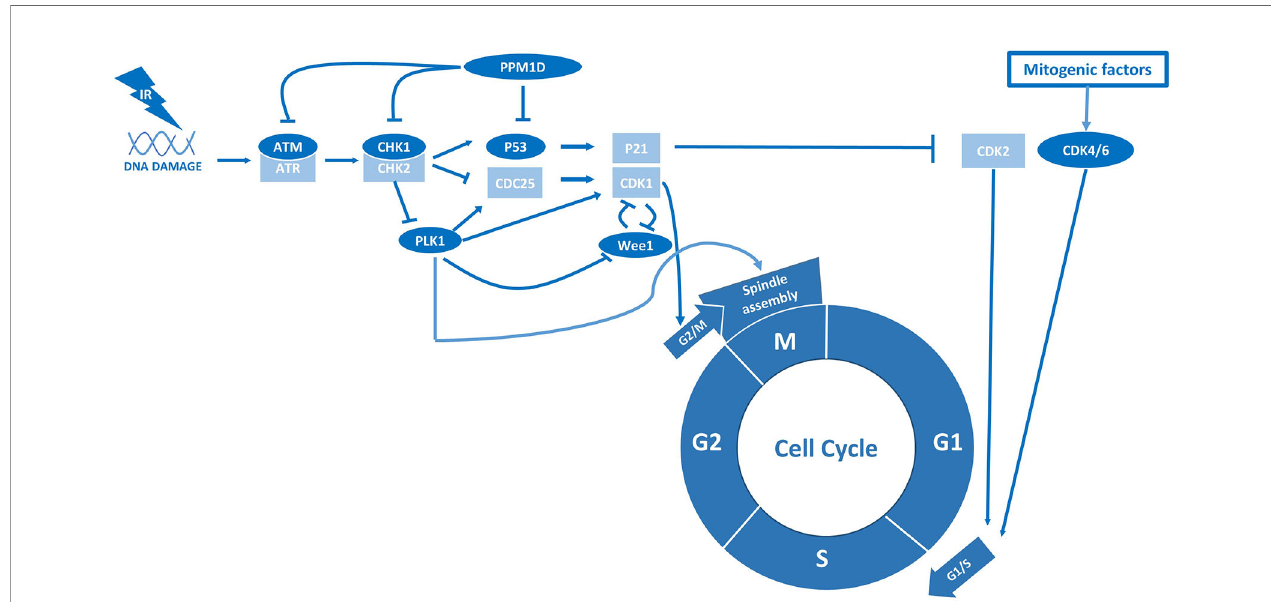
FIGURE 2 | p53 and PPM1D are central regulators of radiation sensitivity in